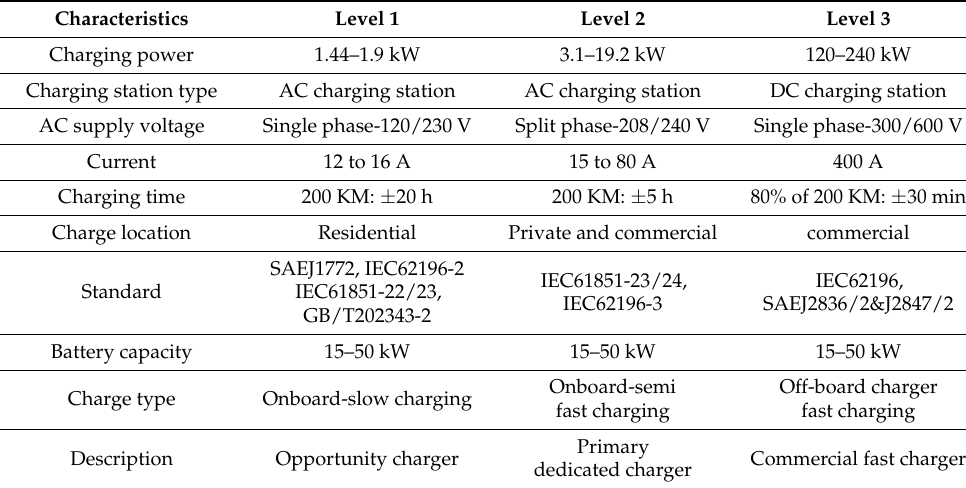
Table 4. Comparison of parameters related to different charging levels of EVs